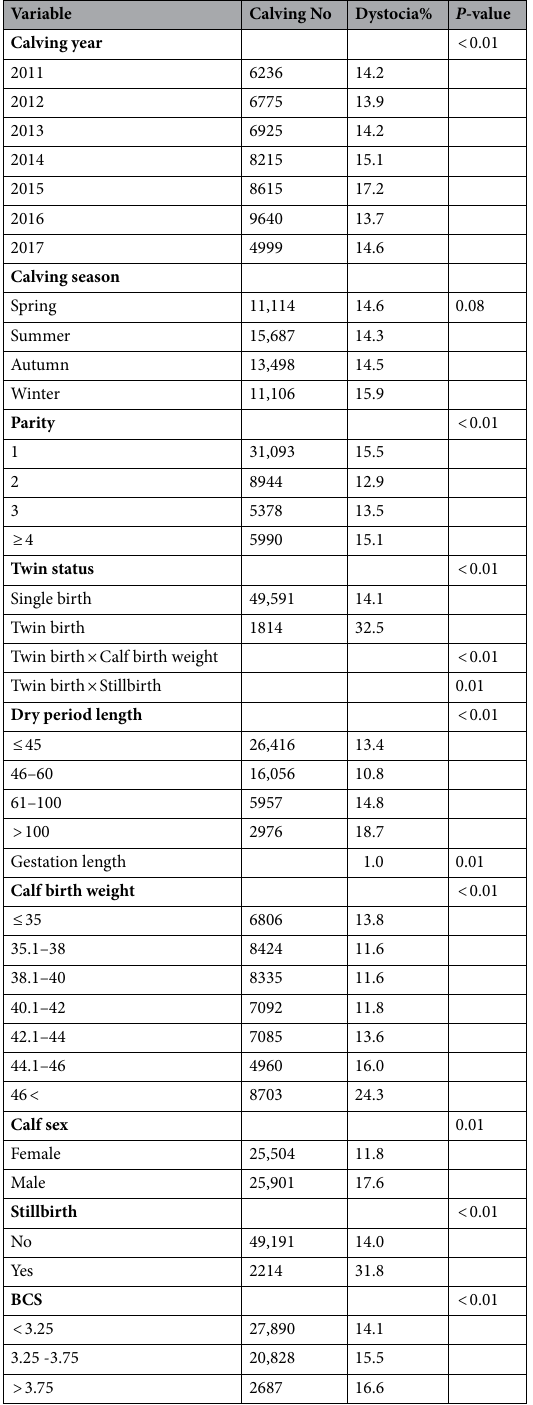
Table 3. Calving number and percentage of stillbirths for variables included in the binary logistic regression model of the generalized linear mixed model for cow-level risk factors for dystocia incidence in Holstein dairy cows (n =